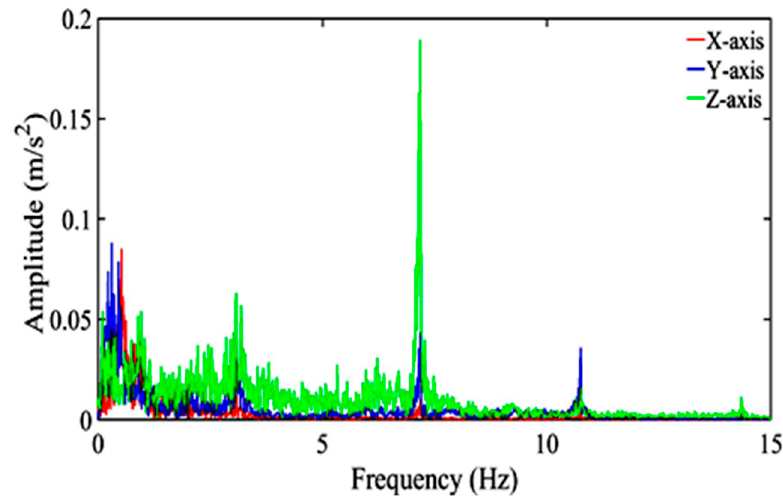
Figure 8. Fast Fourier response in harrowing operations.